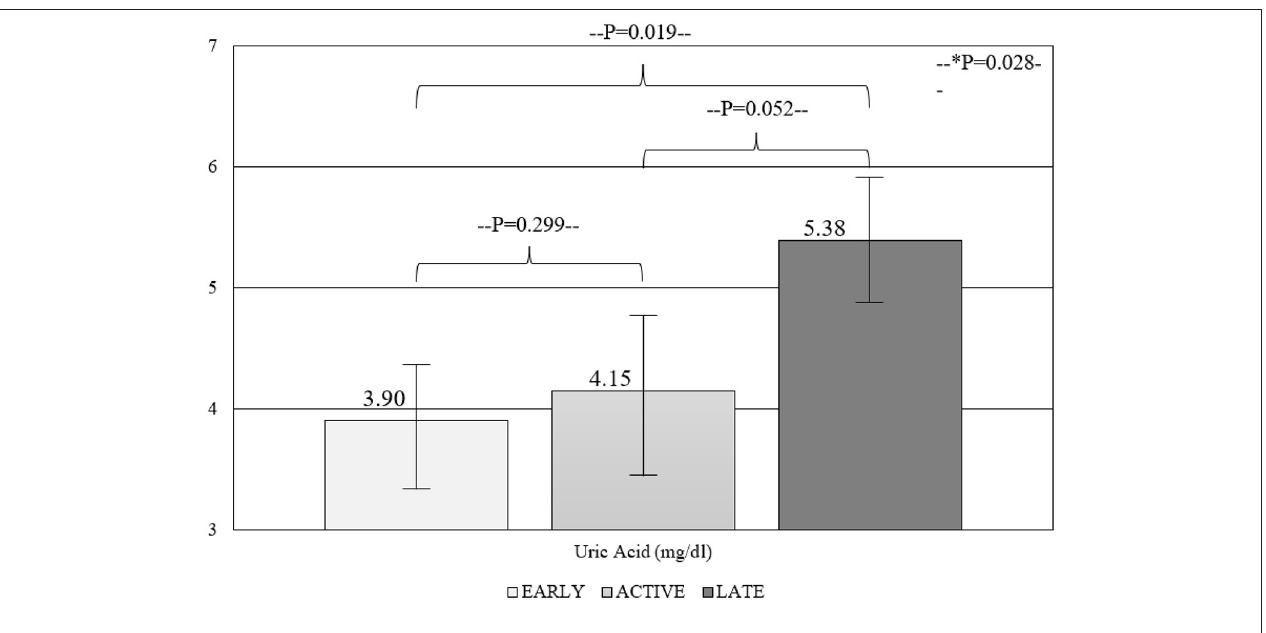
FIGURE 1 | Comparison of UA in the three NVC patterns.